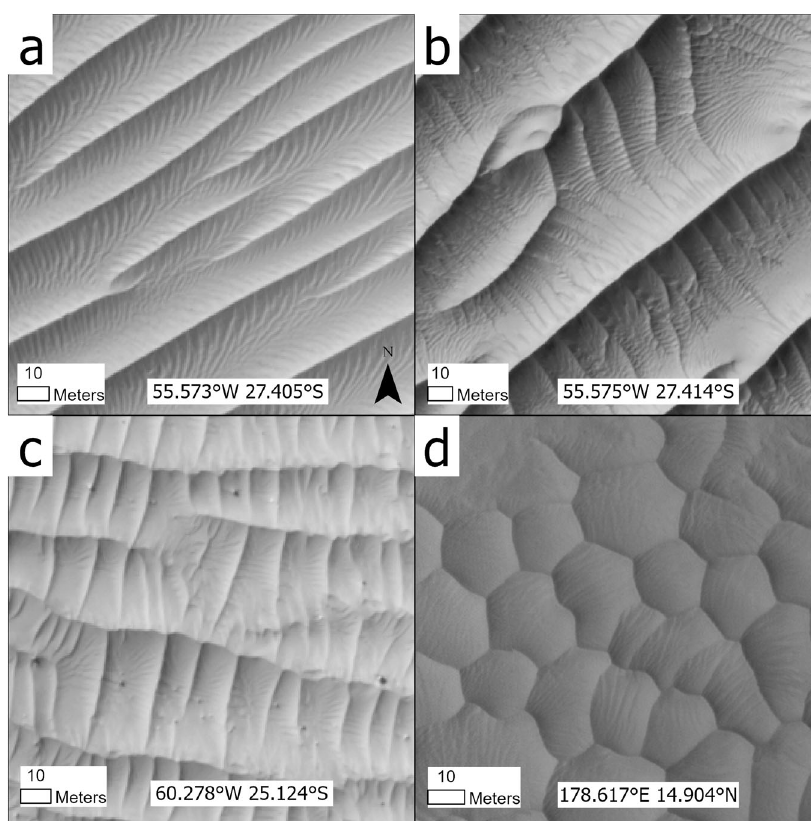
Fig. 1 The progression from simple linear TARs to networked TARs. a Secondary ridges form on larger ridges, producing “ feathered ” TARs 34,35 (ESP_018597_1525). b These secondary ridges become larger and more prominent — often with the formation of tertiary ridge features perpendicular to the secondary crests (ESP_018597_1525). c Secondary ridges enlarge and become principal morphological features, forming regular rectangular cells (ESP_017661_1545). d Rectangular cells form into a hexagonal network (ESP_064491_1950). Coordinates mark the center of each image. North is up in these and the following images. All HiRISE images credit to NASA/JPL/University of